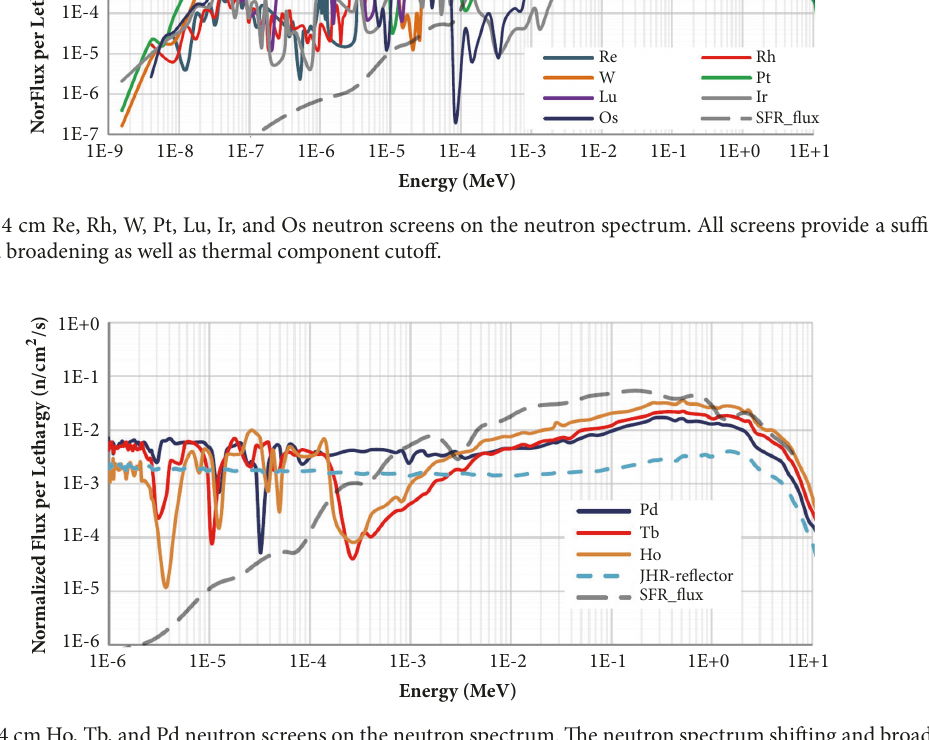
between 1MeV and 5 MeV, while Pt, Lu, and Rh have lower 𝜎 with maximum occurring at ∼